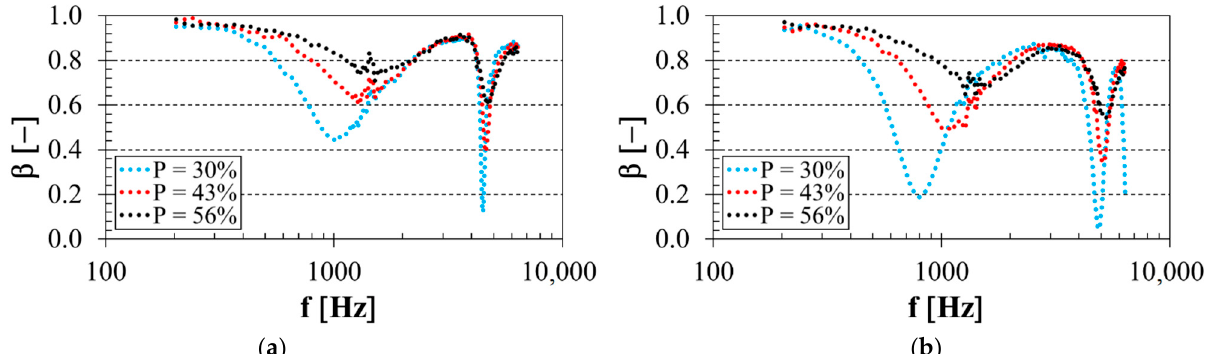
Figure 5. Effect of total volume porosity on the frequency dependencies of the sound reflection coefficient for the investigated PLA specimens: ( a ) rhomboid structure, sample thickness t = 10 mm, air gap size a = 40 mm; ( b ) cartesian structure, sample thickness t = 20 mm, air gap size a = 30 mm.